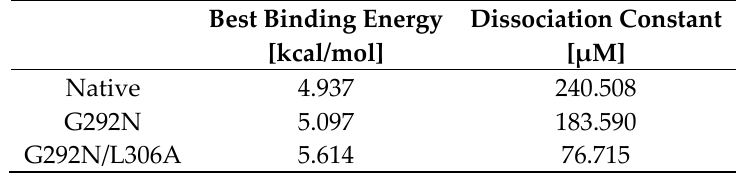
Table 1. Molecular docking results of L-DOPA on native Tt PPO and mutants G292N, G292N/L306A.